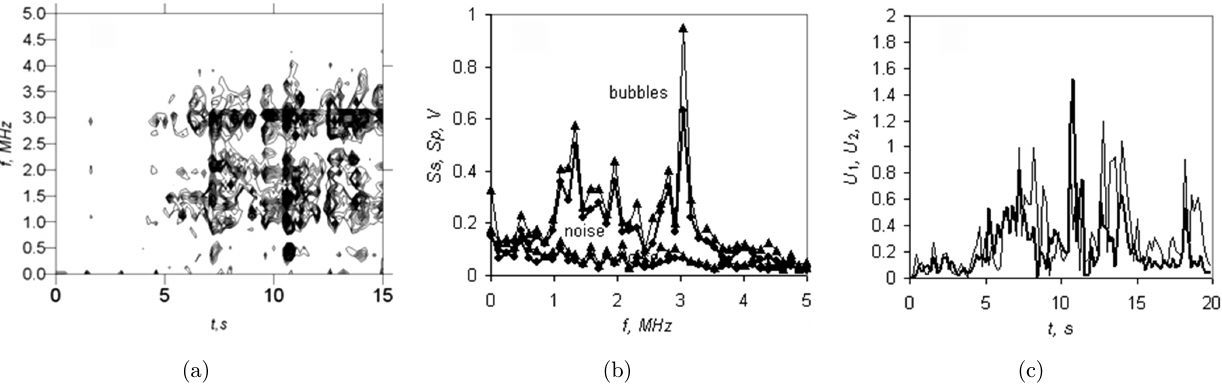
Fig. 5. Instantaneous signal (a) and current signal (b) in relation to the spectrum and the change of amplitude of the f 1 and f 2 frequencies with laser